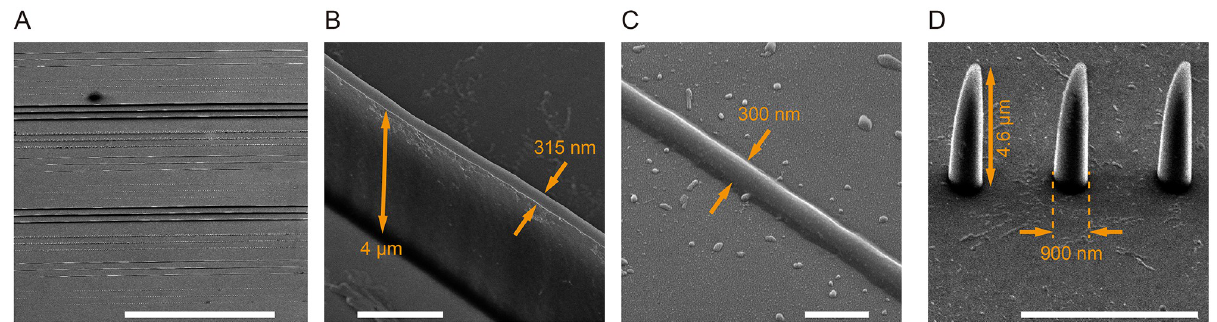
Fig 5. Structures form factor. (a) Overall SEM view of array of dots and lines written with three simultaneous polymerizing spots projected holographically at different laser power and dwell time. Scalebar is 200 μ m. (b, c) Details of two lines in panel (a) written with laser power/writing speed 59.4mW/10 μ m/s (estimated power density of 10.08 TW/cm 2 per spot [23]) and 32.6mW/20 μ m/s (estimated power density of 5.53 TW/cm 2 per spot [23]), respectively; scalebars are 2 μ m (panel b) and 500 nm (panel c). (d) Details of dots pattern in (a) written with laser power 59.4mW (estimated power density of 10.08 TW/cm 2 per spot [23]) and dwell time 100 ms; scalebar is 5 μ m.